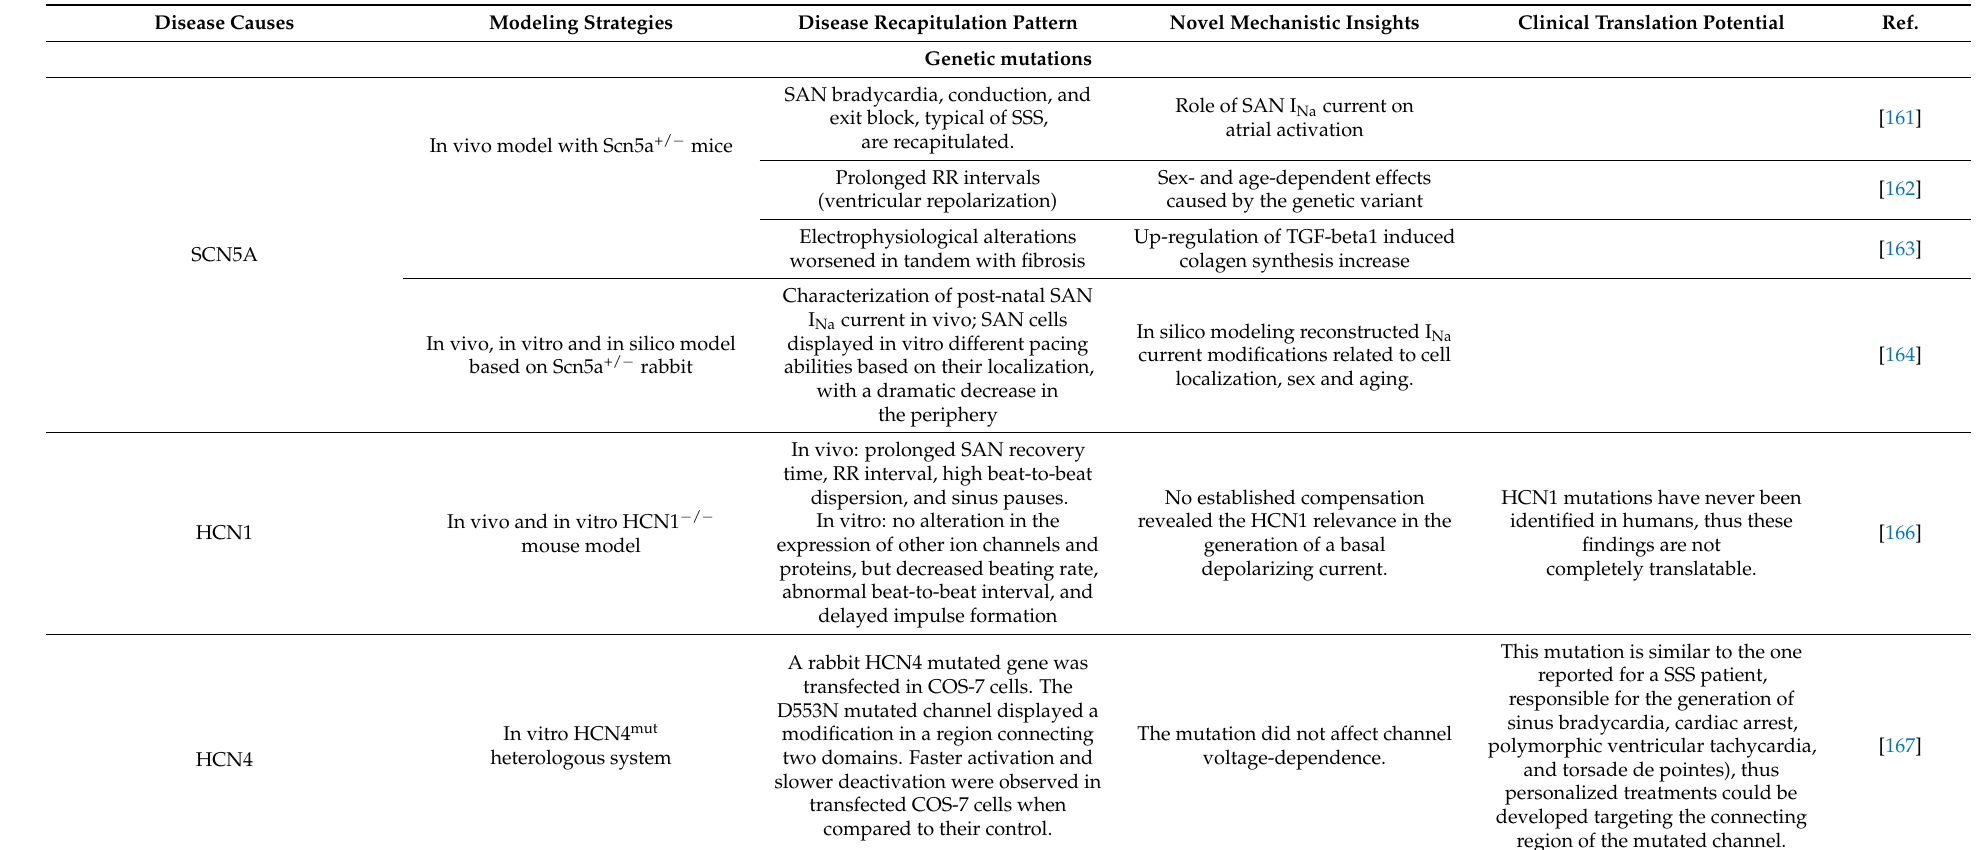
Table 1. Sick Sinus Syndrome (SSS): causes, modeling strategies, and their clinical